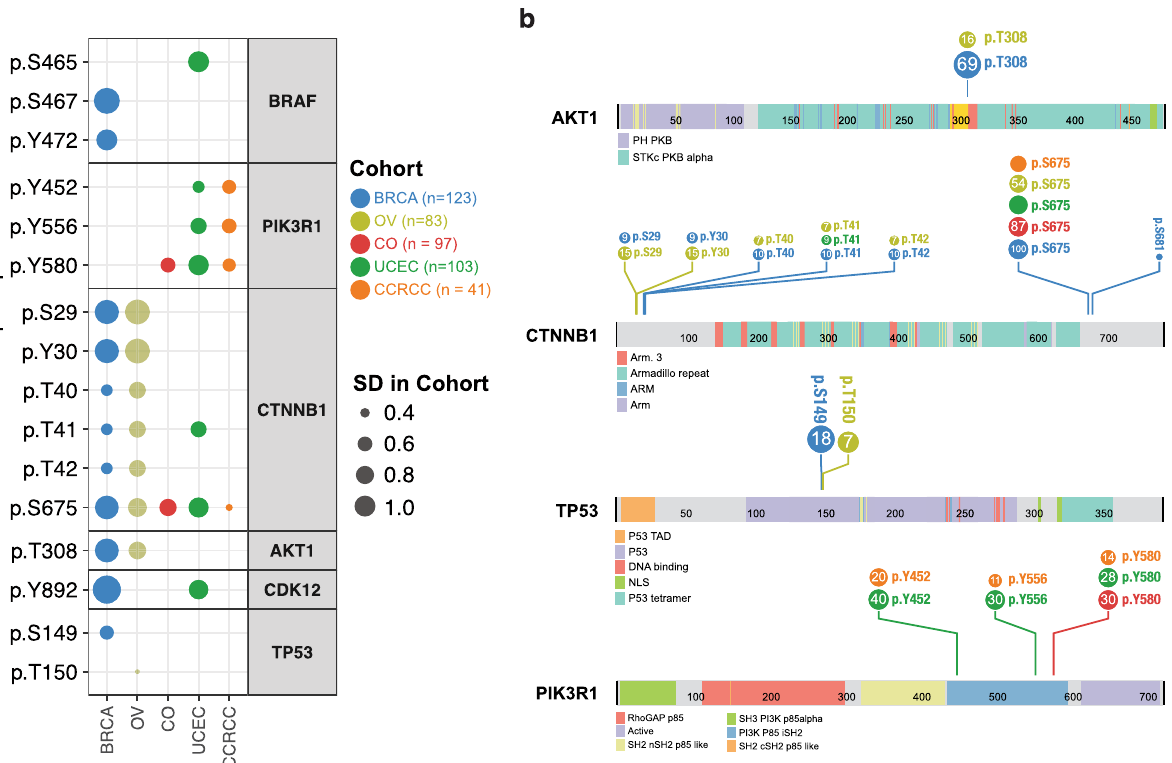
Fig. 6 Veri fi cation of co-clustering phosphosites in primary tumors. a Veri fi cation of co-clustering phosphosites of cancer proteins in patient tumor samples characterized by the CPTAC prospective projects. Each dot represents the phosphosites being detected in the cancer cohort colored-coded by cancer type. The size of the dot represents the standard deviation of the phosphosite level in the respective cancer cohort. b Lolliplots showing number of tumor samples (number in circle) where the co-clustering phosphosites of AKT1, CTNNB1, TP53, and PIK3R1 proteins are detected in each cancer cohort out of 123 breast invasive carcinoma (BRCA), 83 ovarian carcinoma (OV), 97 colorectal adenocarcinoma (CRC), 103 uterine corpus endometrial carcinoma (UCEC), and 41 clear cell renal cell carcinoma